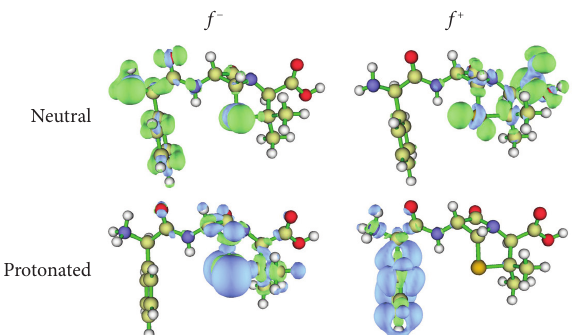
Figure 9: Fukui indices for the electrophilic ( f + ) and nucleophilic ( f − ) sites for two states of AMP visualized at 0.002 isosurfaces. Fe (110) + AMP